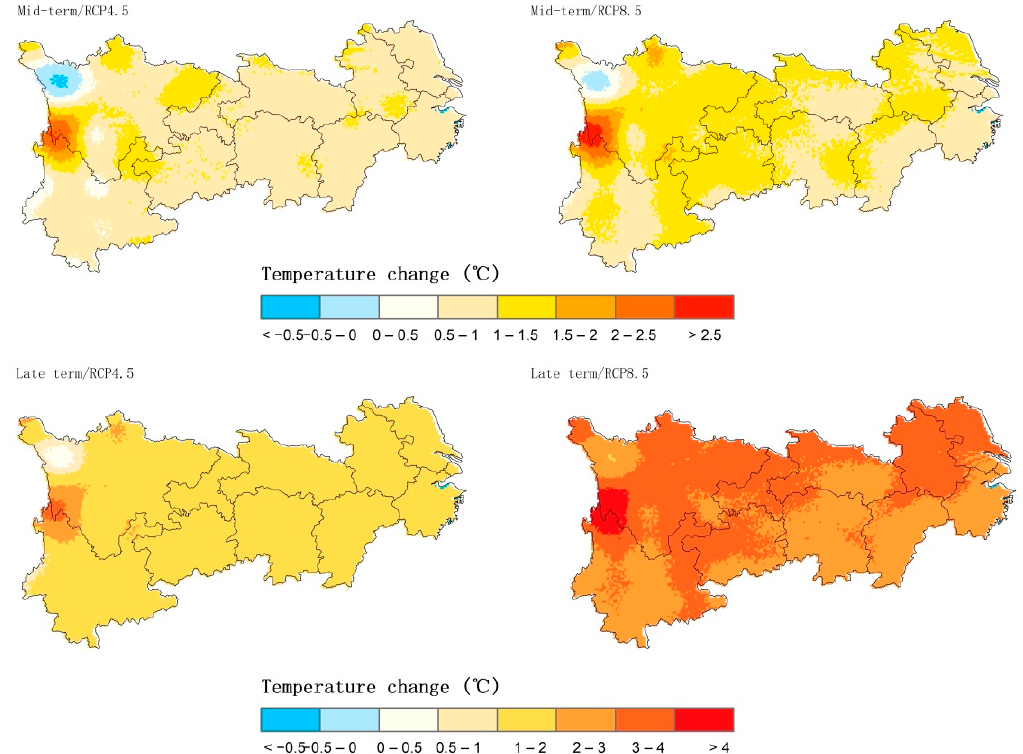
Figure 9. Mean air temperature change patterns in the mid–term and late–term 21st century compared with the reference period under the RCP4.5 and RCP8.5 scenarios.